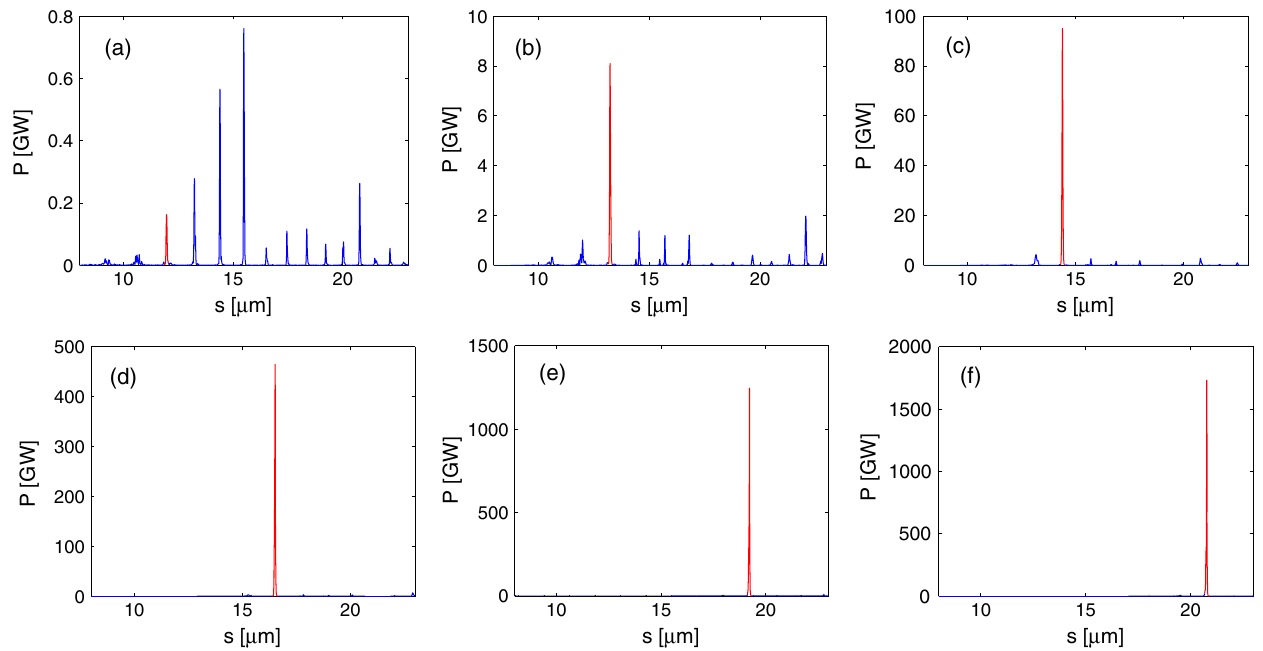
FIG. 3. XFEL radiation structure evolutions along the undulator beam line at the end of (a) the 1st, (b) the 2nd, (c) the 3rd, (d) the 5th, (e) the 8th, and (f) the 10th undulator